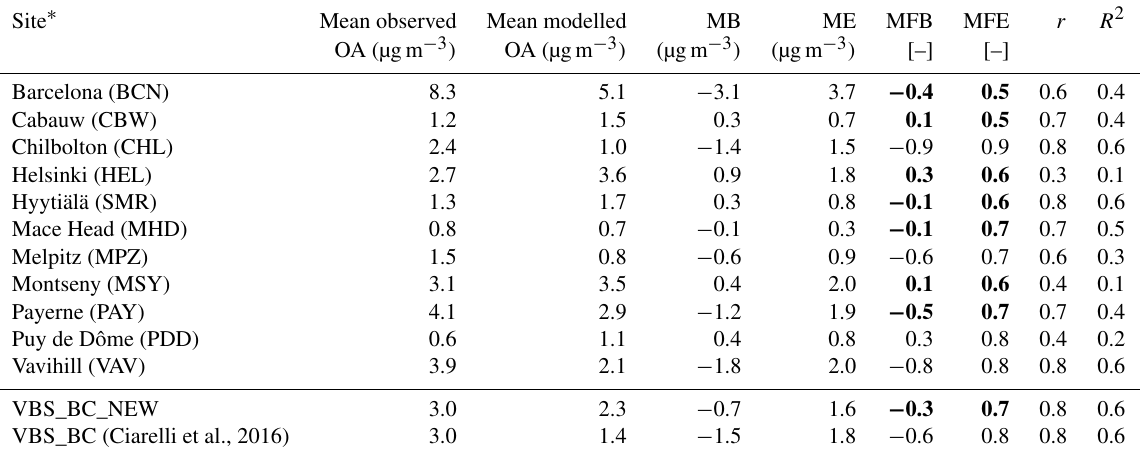
Figure 2. Daily average scatter plots for OA concentrations at 11 AMS sites for the period between 25 February and 26 March 2009 for VBS_BC (left) and VBS_BC_NEW case (right). Solid lines indicate the 1:1 line. Dotted lines are the 1:2 and 2:1 lines. Table 2. Statistics of OA for the VBS_BC_NEW case for February–March 2009 at each AMS site as well as an average of all sites for both VBS_BC_NEW and VBS_BC. Bold numbers represent the stations where model performance criteria were met. Site